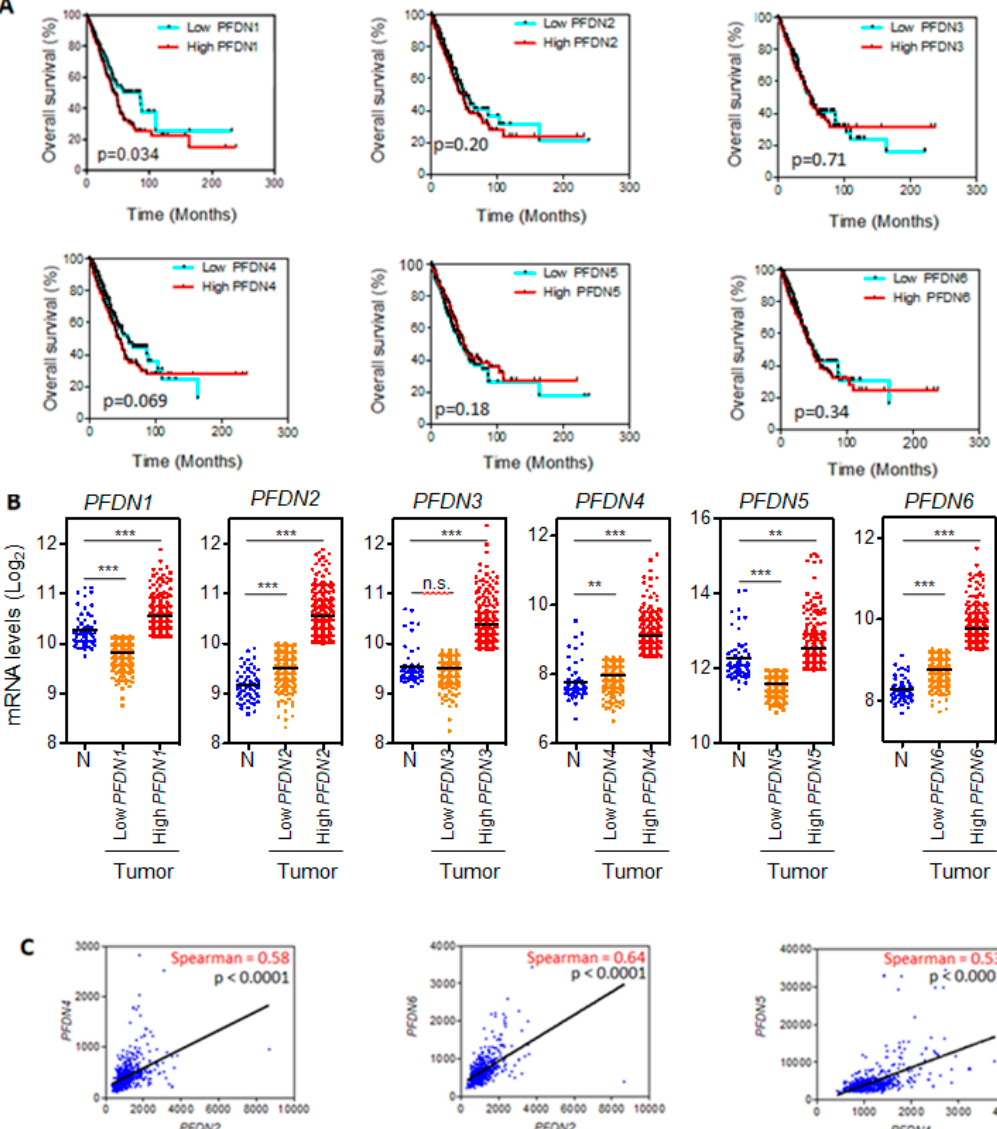
Figure 1. ( A ) Kaplan–Meier curve of The Cancer Genome Atlas (TCGA) lung cohort for overall survival according to low vs. high expression of prefoldins ( PFDNs) (cut o ff point: 50%); ( B ) Levels of PFDNs t ranscripts in tumors and normal tissue (Abbreviations: N, normal; n.s., not significant; *** p < 0.0001; ** p < 0.001). Tumor samples were divided into two categories: low and high expression of PFDNs as in ( A ); ( C ) Significant correlations between mRNA levels of di ff erent PFDN genes in tumor samples. RNA-seq expression data are provided as RNA-Seq by Expectation Maximization (RSEM) normalized data.